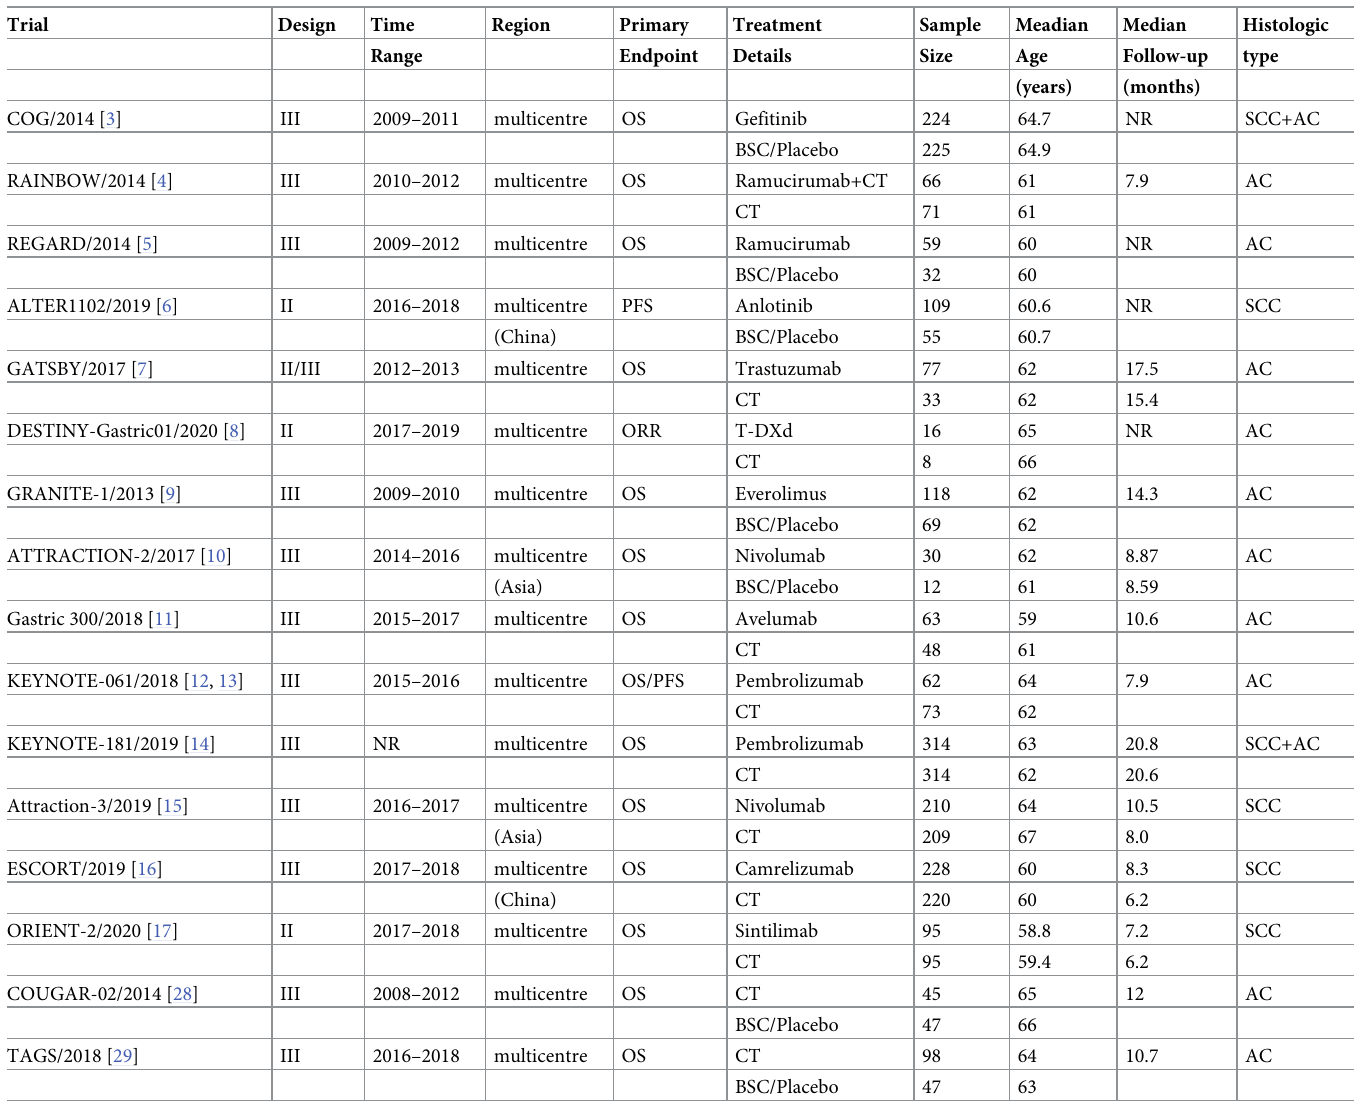
Table 1. Characteristics of included